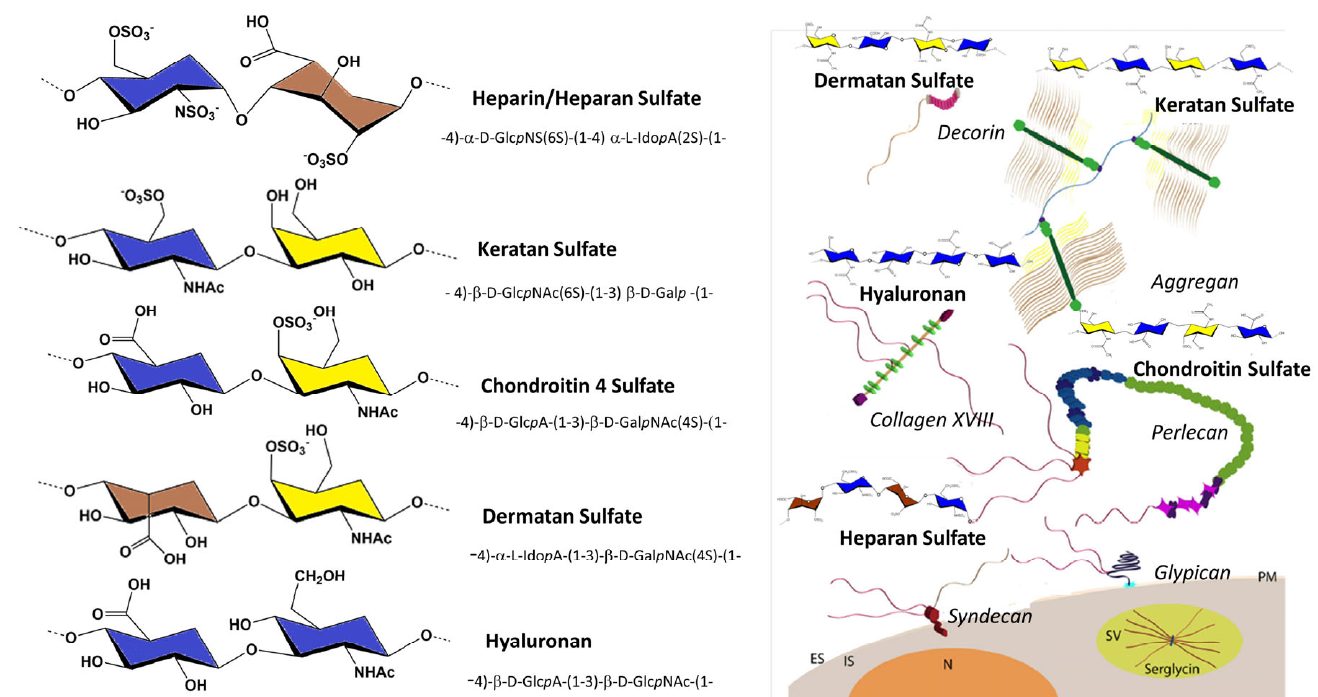
Figure 1. Cartoon representation of the chemical constitution of the five families of GAGs and of six categories of proteoglycans (aggrecan; decorin, perlecan, and collagen; glypican; and syndecan and serglycin). ES, extracellular; IS, intracellular; N, nucleus; SV, secretory vesicle. (Adapted from K. Rodgers, J.D. San Antonio, O. Jacenko. Dev Dyn. 2008, 237,